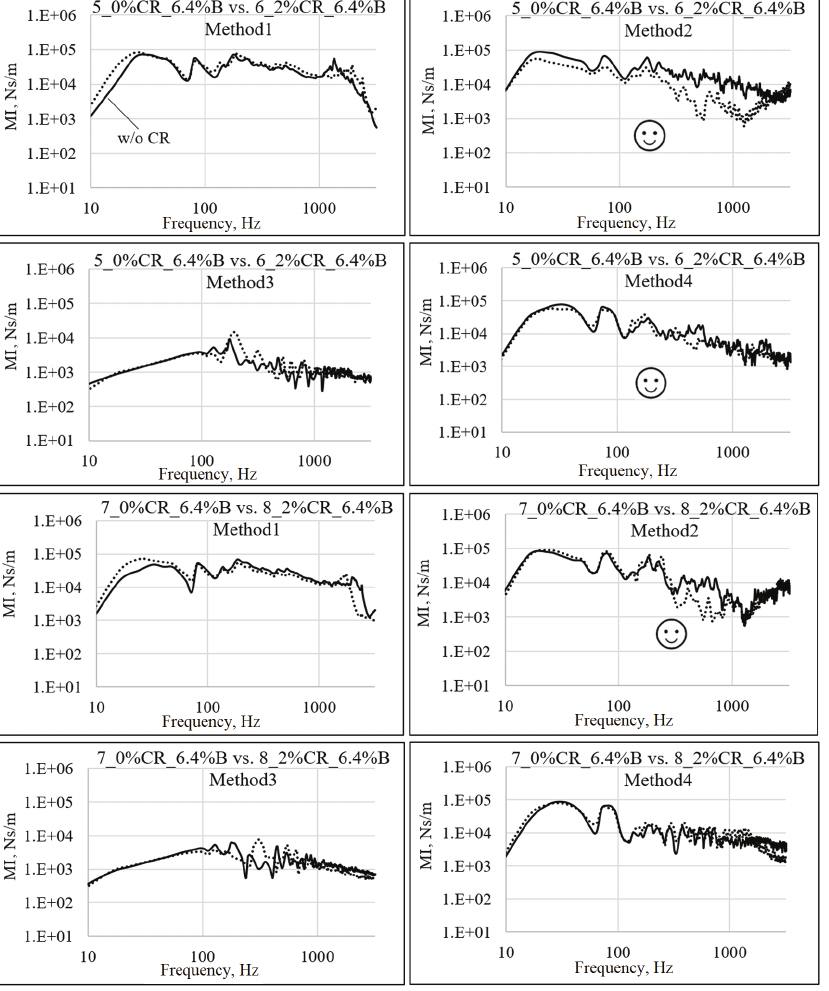
Figure 10. Comparison of Mechanical Impedance between 0%CR and 2%CR considering the four methods